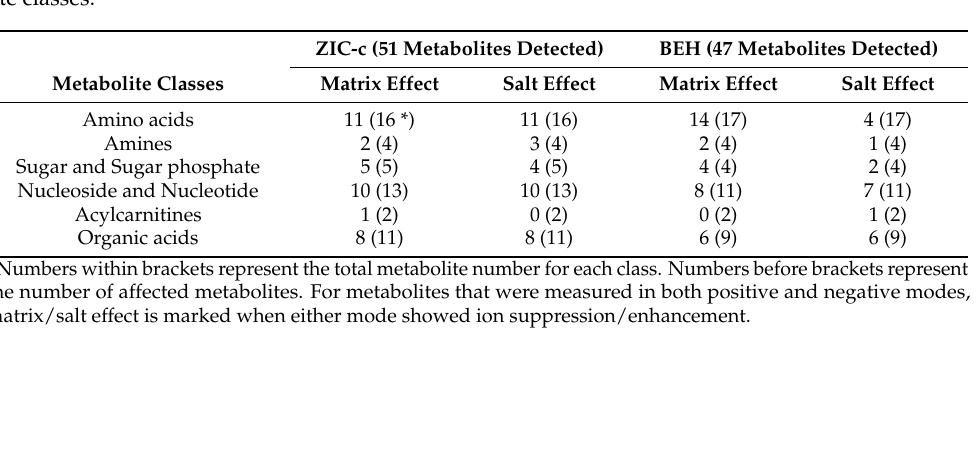
Figure 3. Extracted ion chromatogram of metabolites influenced by sodium chloride on the ZIC-c HILIC and BEH-amide columns. Citrulline and glutamine showed the increased MS responses of sodium adducts in plasma and salt sample (pure sodium chloride solution) versus neat sample (no sodium chloride). Tryptophan and adenosine showed the increased MS responses of chloride adducts in plasma and salt sample (pure sodium chloride solution) versus neat sample (no sodium chloride). Table 1. Summary of plasma matrix effect and sodium chloride effect on representative metabolite classes.